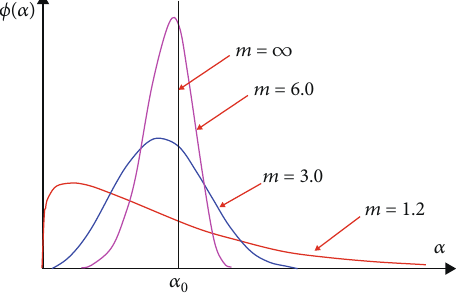
Figure 15: Weibull distribution for material properties with di ff erent indices m